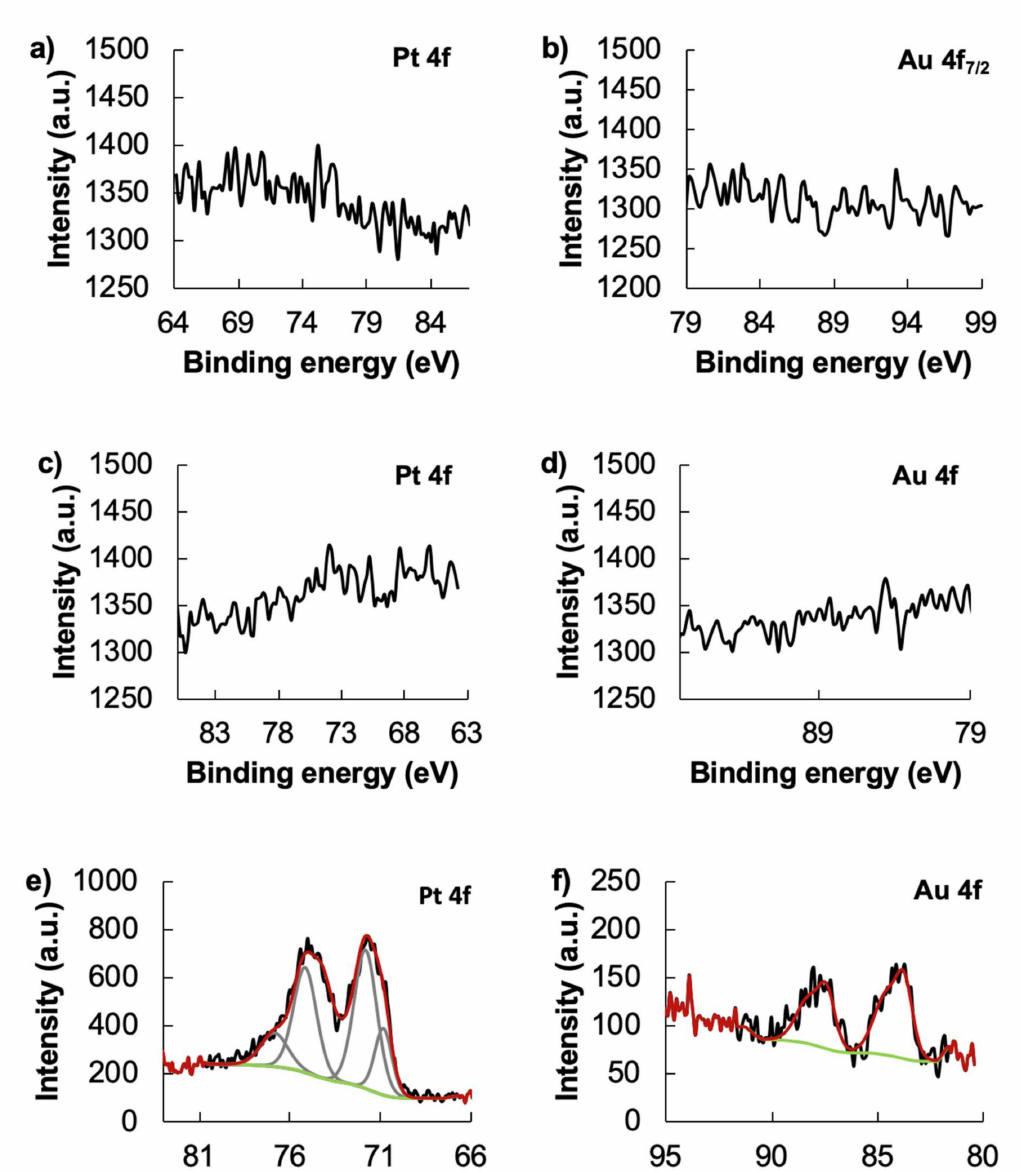
Figure 3. Au and Pt X-ray photoelectric spectra of the characterization of nanocomposite on a glassy carbon electrode (GCE) surface, ( a , b ) tPANI, ( c , d ) tPANI-MWCNT, and ( e , f )